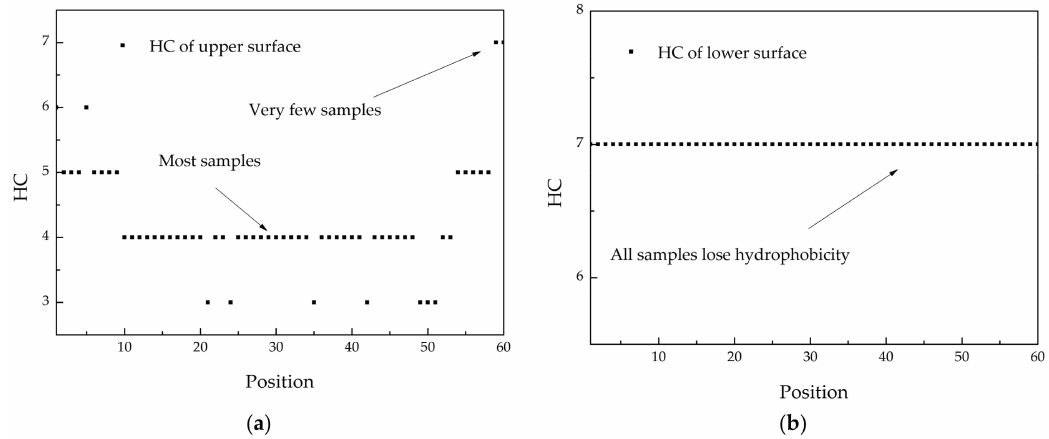
Figure 16. The hydrophobicity of the suspension insulators. ( a ) The upper surface; ( b ) the lower